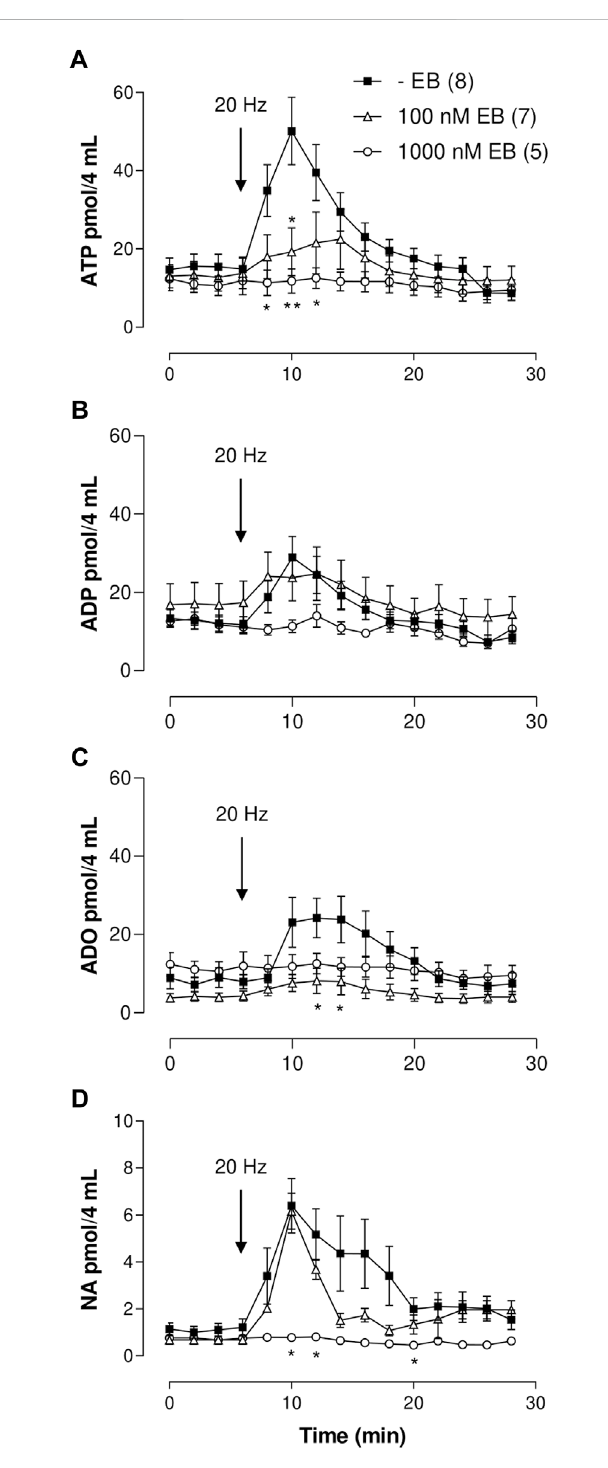
FIGURE 2 ATP/metabolites or NA mesenteric perfusate out fl ow time course elicited by sympathetic nerve terminal depolarization in preparations perfused with either 100 or 1,000 nM Evans blue (EB). (A – D) show the over fl ow of ATP, ADP, ADO, and NA, respectively. Tissues were perfused prior to, during, and after nerve depolarization in the absence (closed squares, n = 8); or presence of either 100 nM EB (open triangles, n = 7) or 1,000 nM EB (open circles, n = 5). Arrows indicate perivascular electrical nerve endings stimulation (20 Hz, 1 ms trains of 60 V during 1 min). *, p < .05, **, p < .01, unpaired t-test as compared to values in the absence of